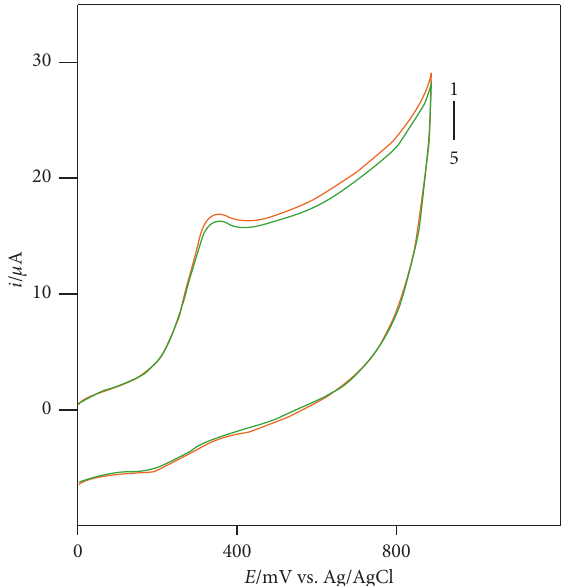
Figure 10: CVs for 0.1mM nevirapine obtained after 5 test runs. Scan rate � 100mV/s in PBS (pH